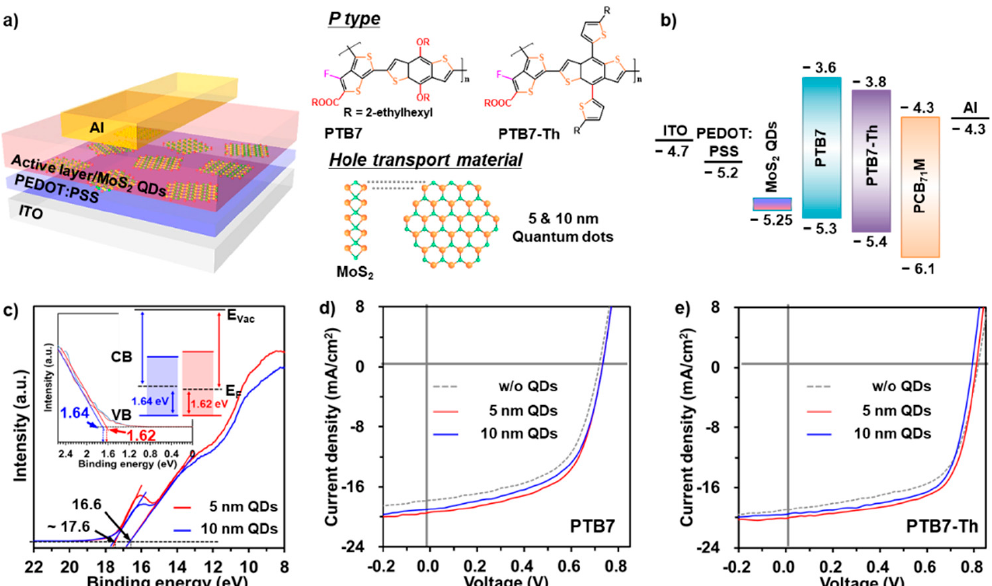
Figure 4. Chemical structures and device characteristics of PTB7 (PTB7-Th):PC 71 BM-based OSCs with/without the 5 ‐ and 10 ‐ nanometer MoS 2 QDs. ( a ) Device structure and molecular structures of donors, acceptor, and MoS 2 QDs. ( b ) Schematic flat energy band diagram. ( c ) Secondary electron threshold region of He-I UPS spectra of the MoS 2 QDs. ( d , e ) J–V characteristics of PTB7-/PTB7-Th-based OSCs.